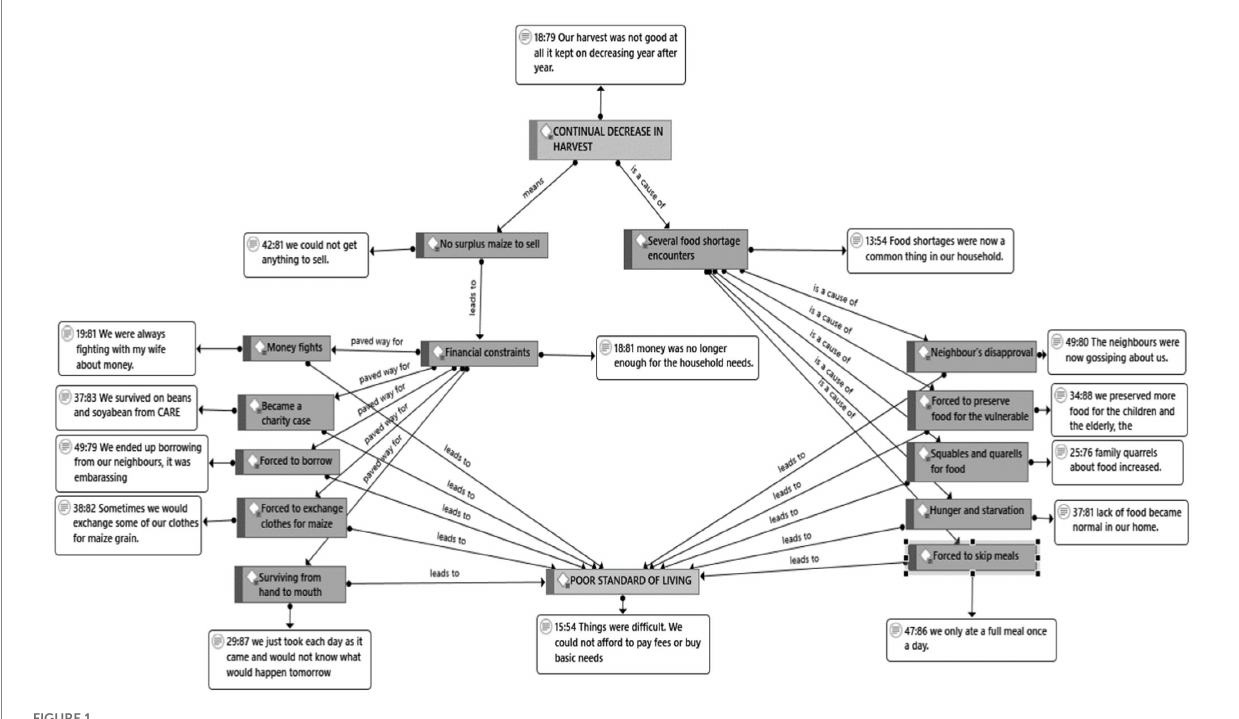
FIGURE 1 Social impacts of climate change on smallholder